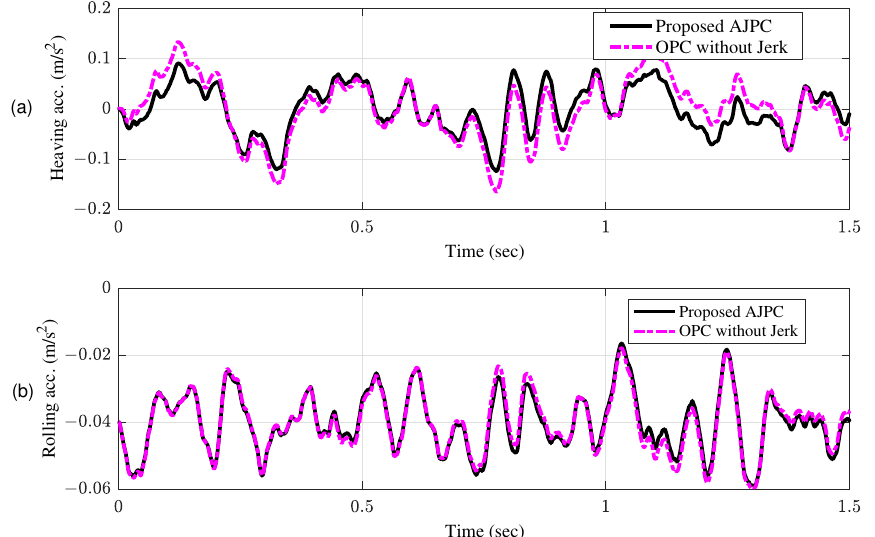
Figure 15. Time domain response of vehicle body acceleration to an asphalt road using proposed AJPC strategy and OPC strategy without jerk; ( a ) heaving acceleration ( b ) rolling acceleration.